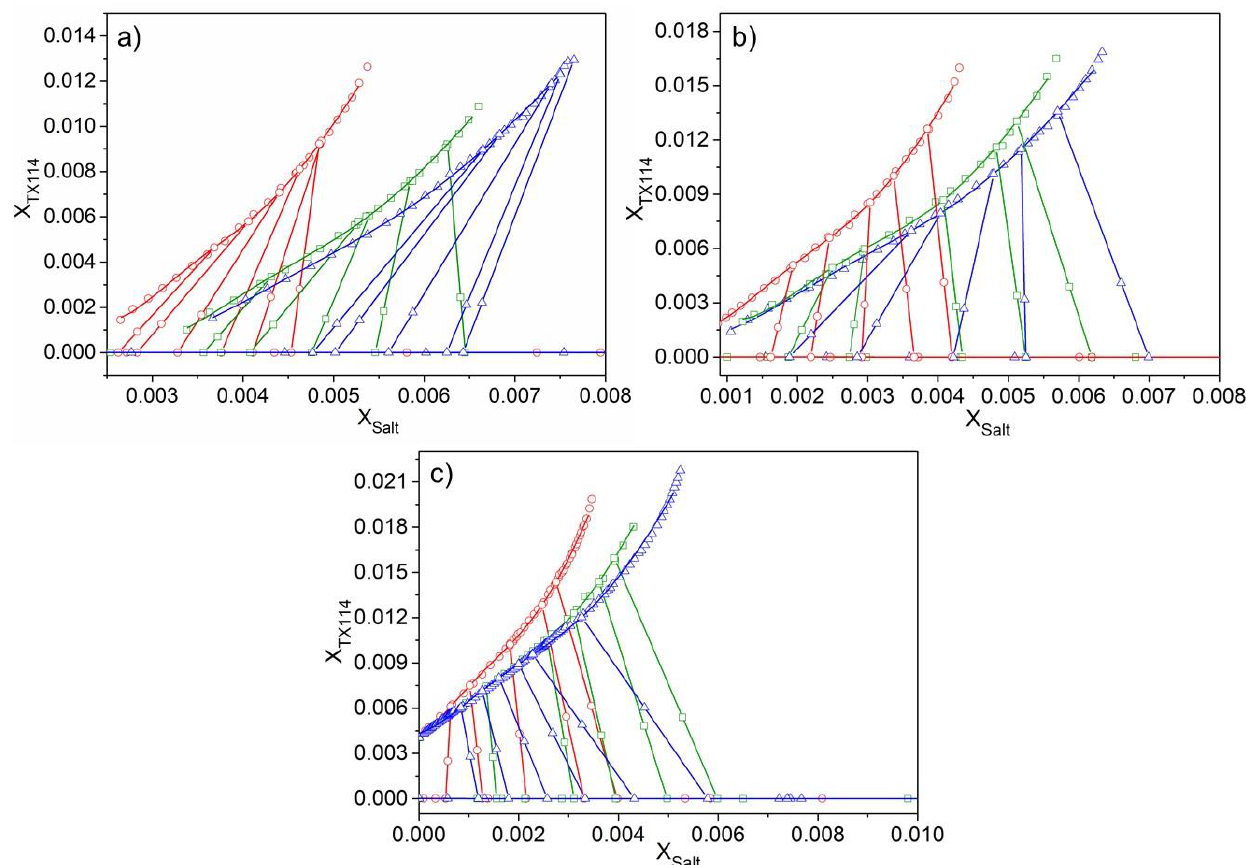
Figure 1. Experimental and calculated binodal curves and tie lines of systems containing TX114 + water + sodium citrate ( -o- ) or sodium sulfate ( - (cid:3) - ) or sodium tartrate ( - (cid:52) - ): ( a ) 283.2 K, ( b ) 293.2 K, ( c ) 303.2